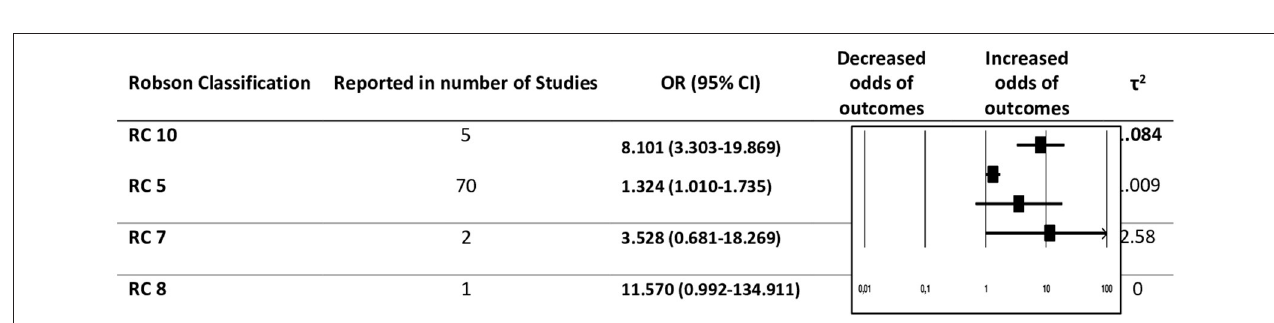
FIGURE 3 | Robson subgroup analysis with summary of pooled odds ratios